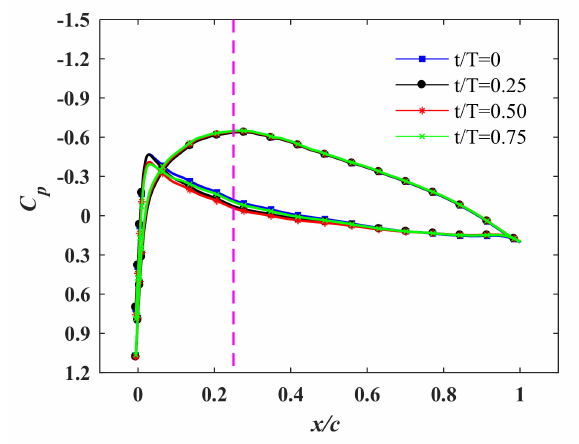
Figure 14. Pressure coe ffi cient distribution of h / c = 0.2 at α = 0 ◦